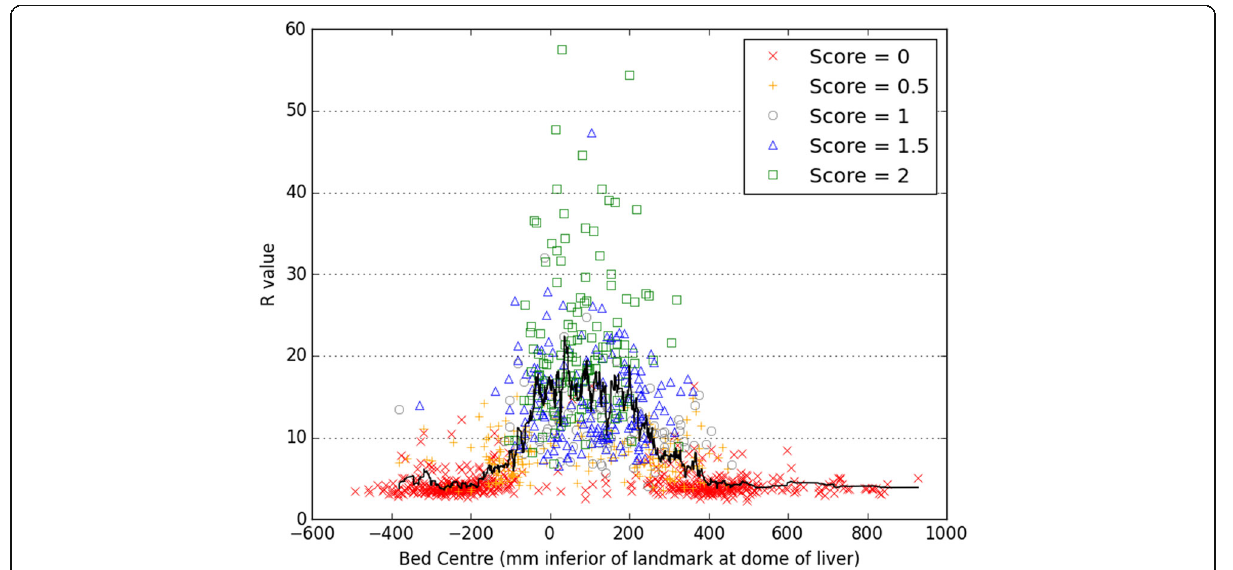
Fig. 5 The R values and scores S for waveforms generated at the different bed positions for 157 patients. A moving average is shown as a solid black line. The most superior point of the liver determined from CT (i.e. the dome of the liver) is used as the reference